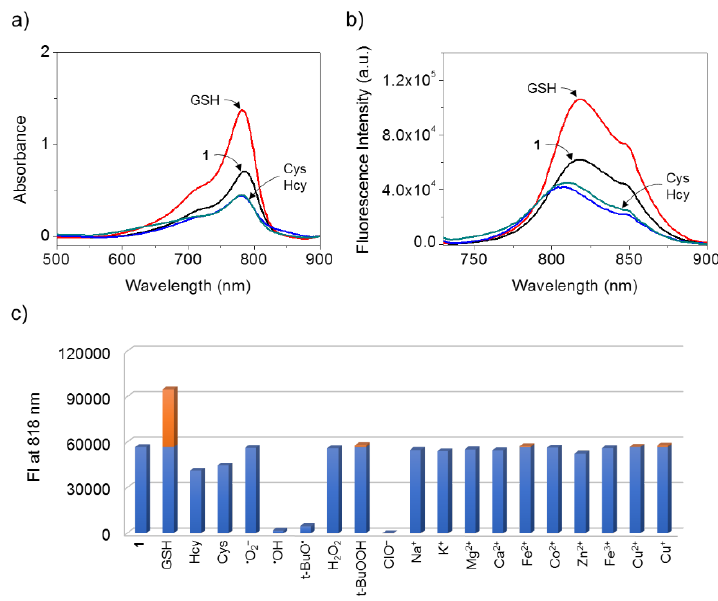
Figure 1. ( a ) UV-Vis absorption and ( b ) fluorescence spectra of 1 (10 μM) in presence GSH, Hcy and Cys (10 mM, respectively). ( c ) Relative fluorescence intensity at 810 nm of 1 to thiols, ROS, and metal ions. All data were obtained in HEPES buffer (10 mM, pH 7.4) containing 1% ( v / v ) of DMSO after incubation of 1 h at room temperature. The excitation wavelength was affected at 720 nm.